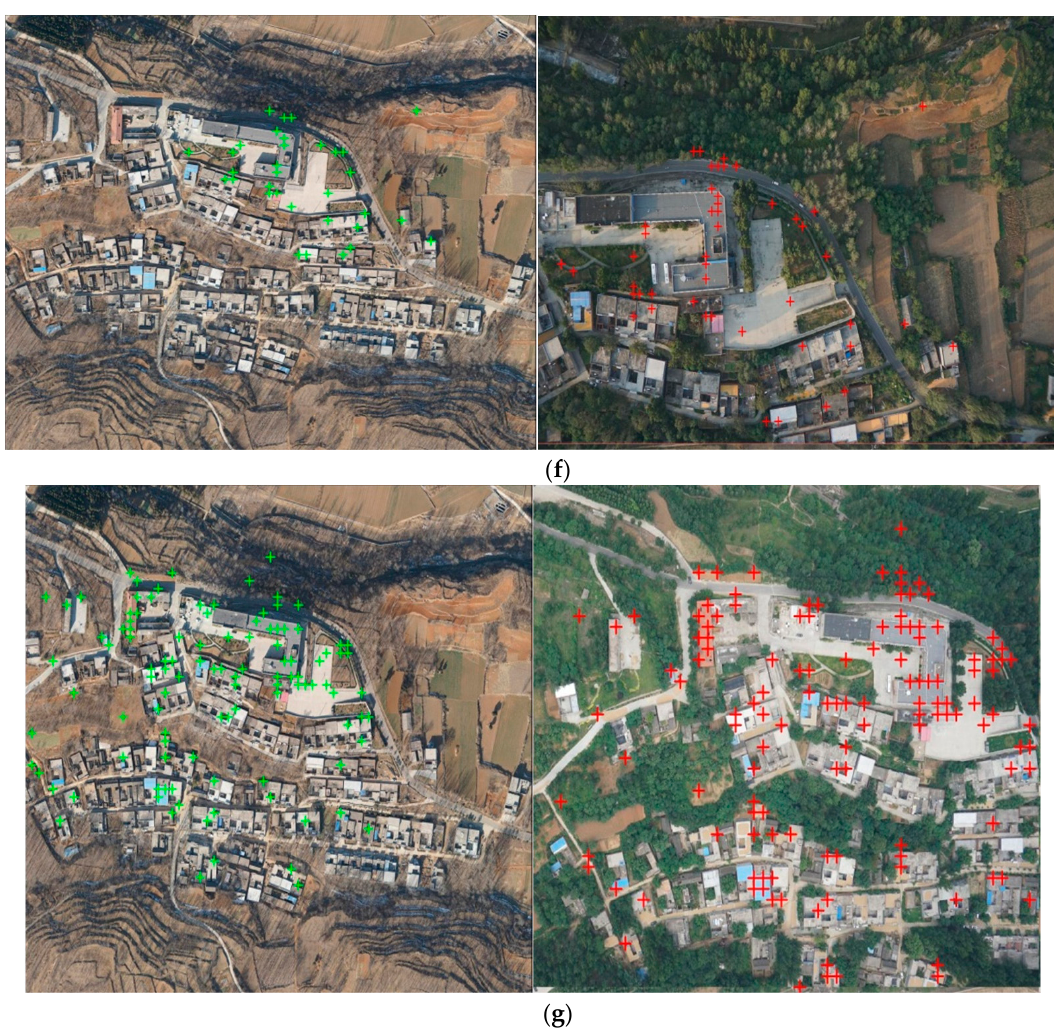
Figure 7. Multi-source image matching based on UAV reference image. ( a ) Case 1: Image matching at different scales; ( b ) Case 2: Image matching with seasonal differences; ( c ) Case 3: Image matching with viewpoint changes; ( d ) Case 4: Image matching with sunny illumination; ( e ) Case 5: Image matching with overcast illumination; ( f ) Case 6: Image matching with sunset illumination; ( g ) Case 7: Image matching with rainy illumination.